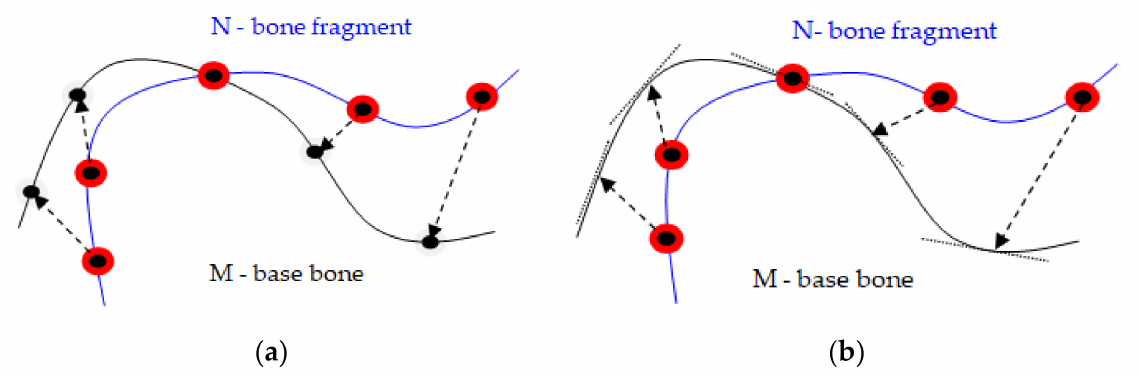
Figure 4. ( a ) Point-to-point method: points are matched to discrete points; ( b ) Point-to-plane method: points are suitable for continuous tangent